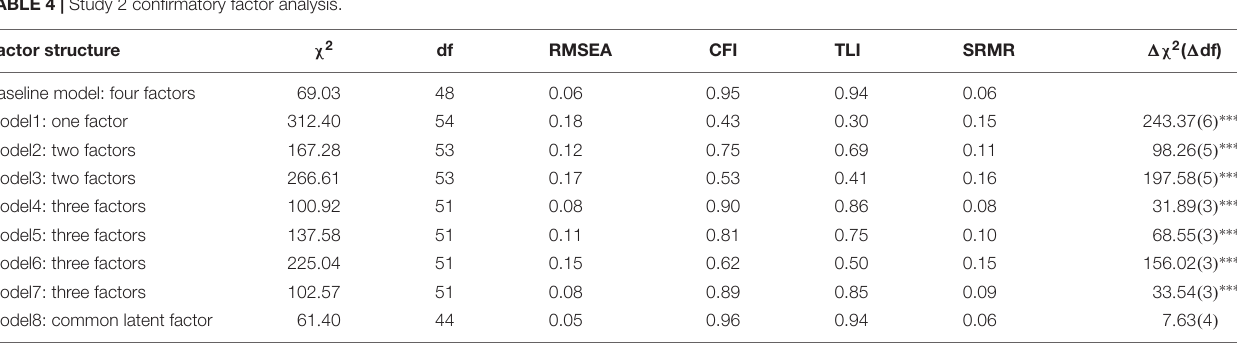
TABLE 4 | Study 2 confirmatory factor